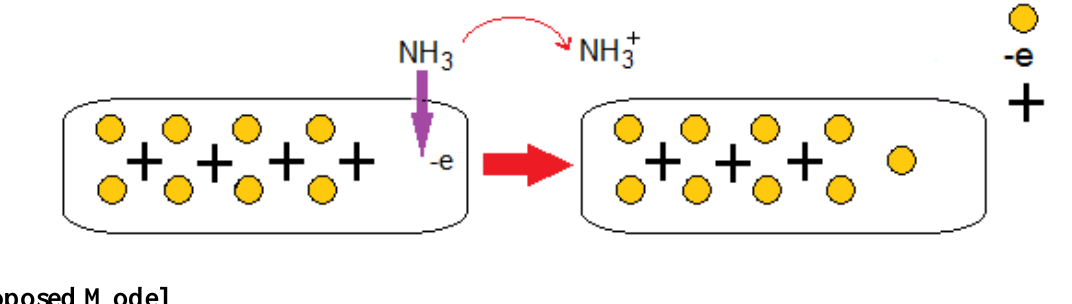
Figure 4. Schematic of NH CNT receives electrons from NH